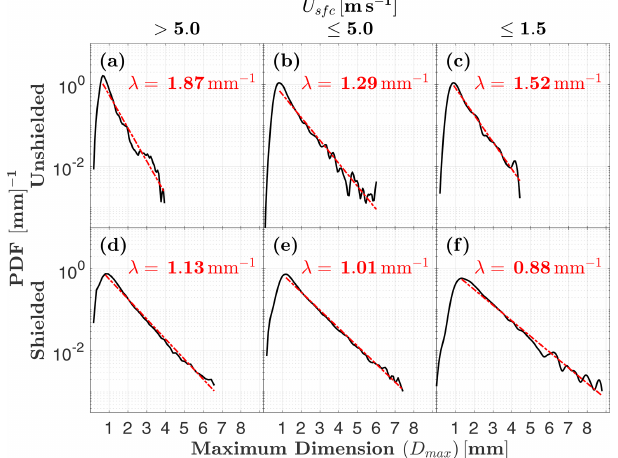
Figure 9. As in Fig. 7 but for maximum dimension D max and slope parameter λ . The slope parameter is calculated as the linear least- squares fit from the peak through the tail of the distribution. Un- shielded and shielded MASC observations are from two separate periods: 29 November 2015–21 August 2016 and 22 August 2016– 28 August 2018, respectively.